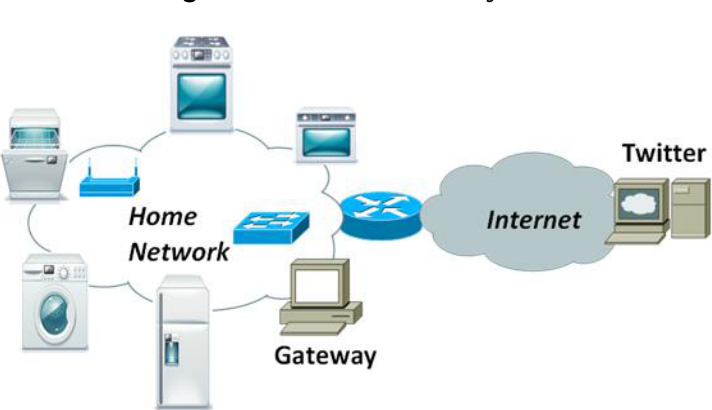
Figure 1. Elements of the system.